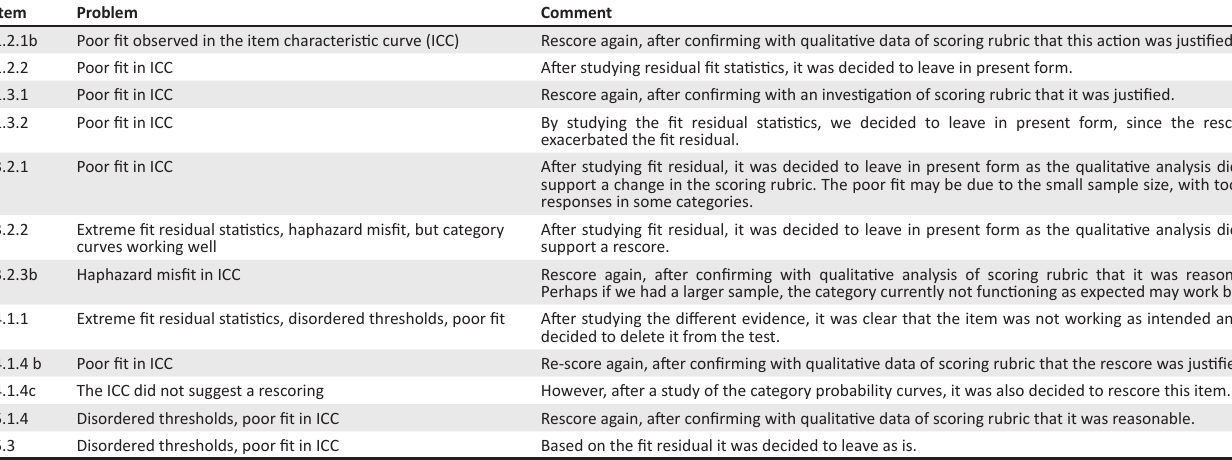
TABLE 1–A: Decisions after results of first round of